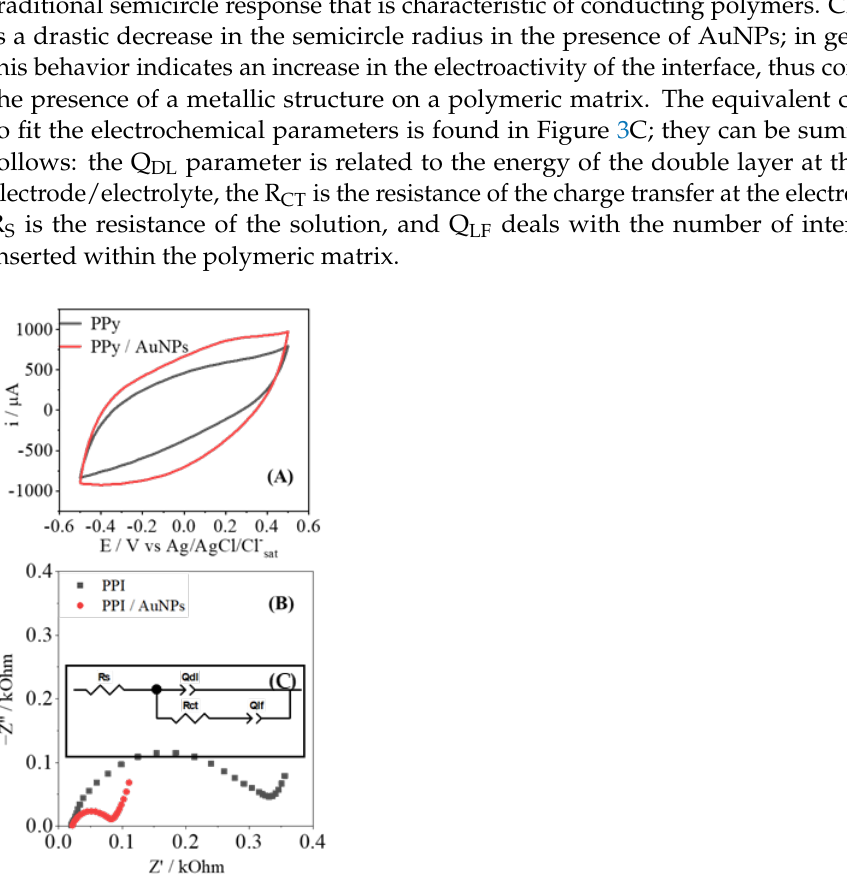
Figure 3. ( A ) CV for the electrodes modified with just PPy (black) and PPy/AuNPs (red). The Nyquist plot is shown in ( B ) from electrodes modified with PPy (black) and with PPy/AuNPs (red). The equivalent circuit used to model the EIS results is also inserted as ( C ).